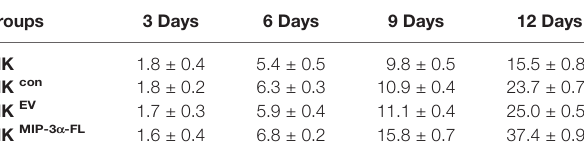
TABLE 2 | Comparison of the frequency of CD3 + CD8 + cells at different time points (%).